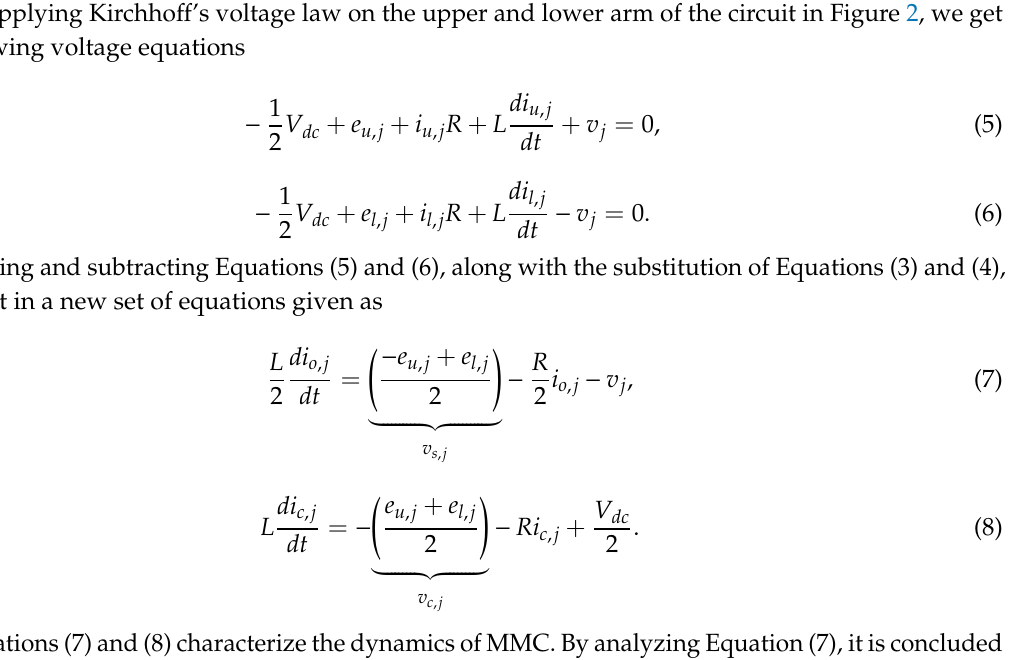
Figure 2. Phase equivalent circuit of MMC .